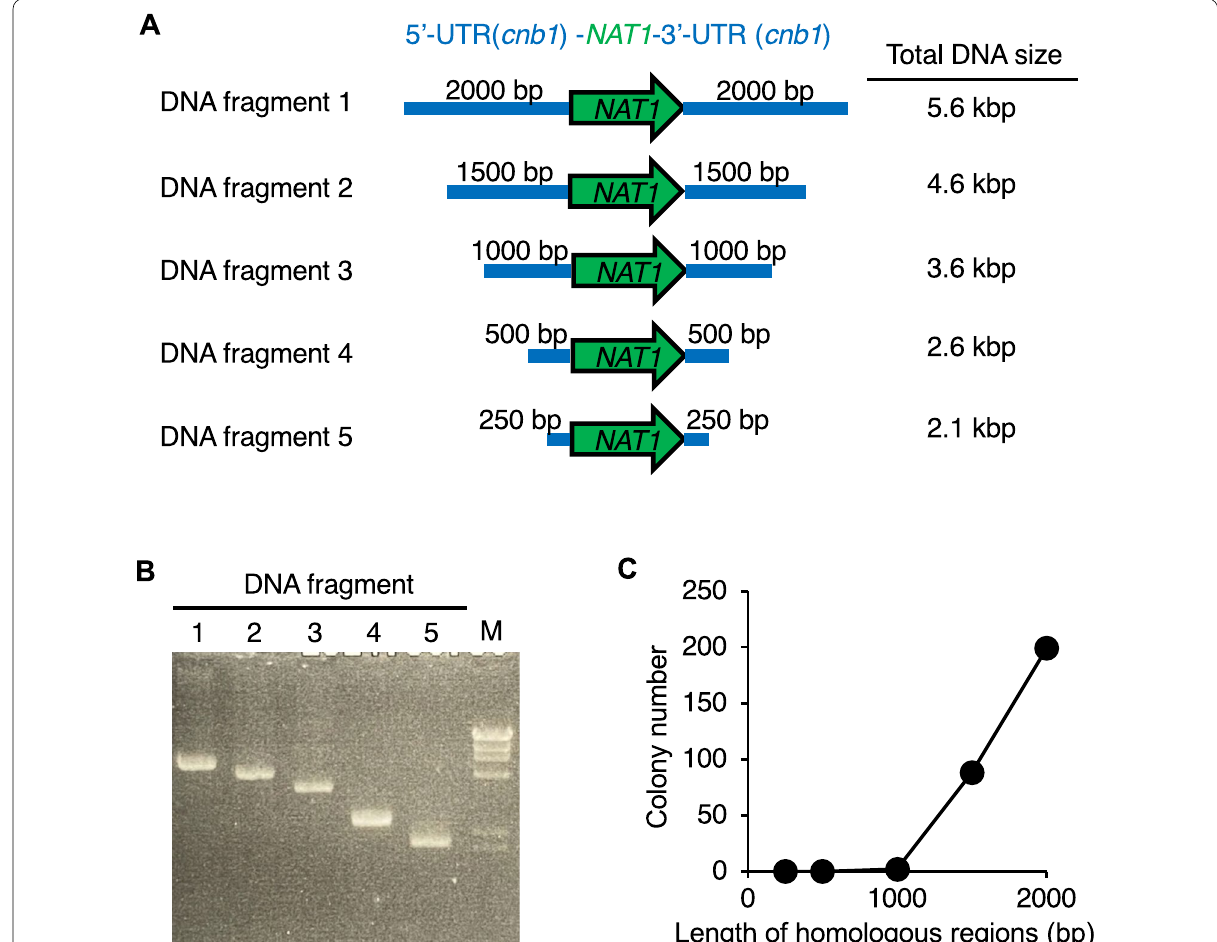
Fig. 2 Effect of the length of homologous regions for gene transfer by electroporation in T. asahii . A Illustration of DNA fragments used in this study. B Electrophoresis of DNA fragments amplified by PCR. C The PCR-amplified 5 ʹ -UTR ( cnb1 ) - NAT1 -3 ʹ -UTR ( cnb1 ) fragments were added to the competent T. asahii cells prepared by culture for 1 day and electroporated (time constant protocol: 1.8 kV, 5 ms). The number of colonies grown on SDA containing nourseothricin (300 µg/ml) was